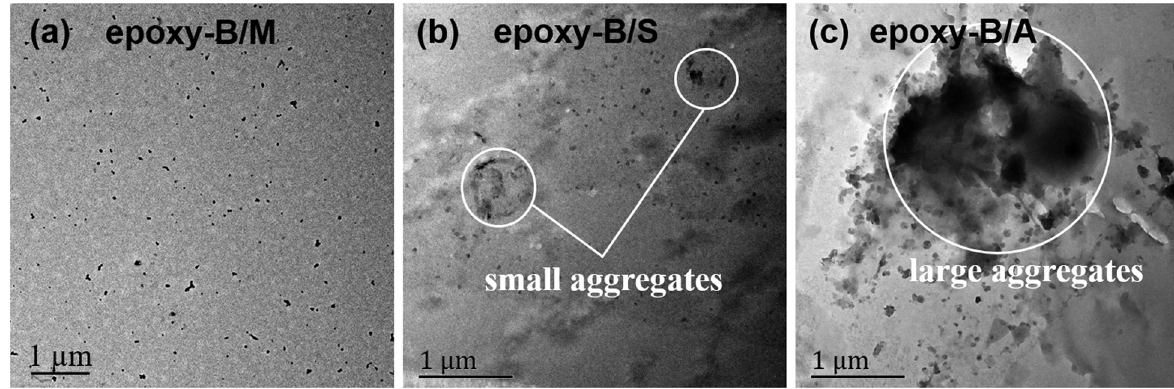
Figure 2: TEM images showing the dispersed nanoparticles in epoxy resin: B/M ( a ) , B/S ( b ) and B/A ( c ) .